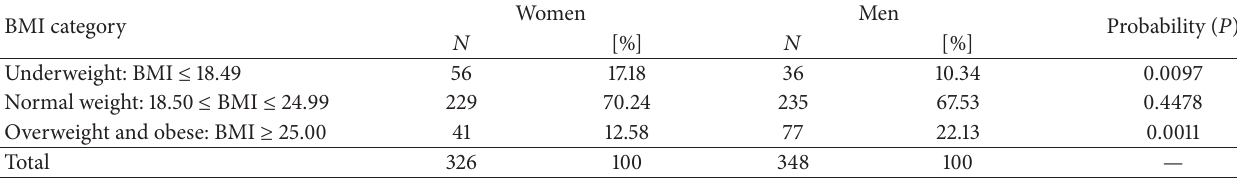
Table 2: Basic somatic parameters and sauna-induced BML in the tested subjects. Somatic parameters, BMI, and BML Women